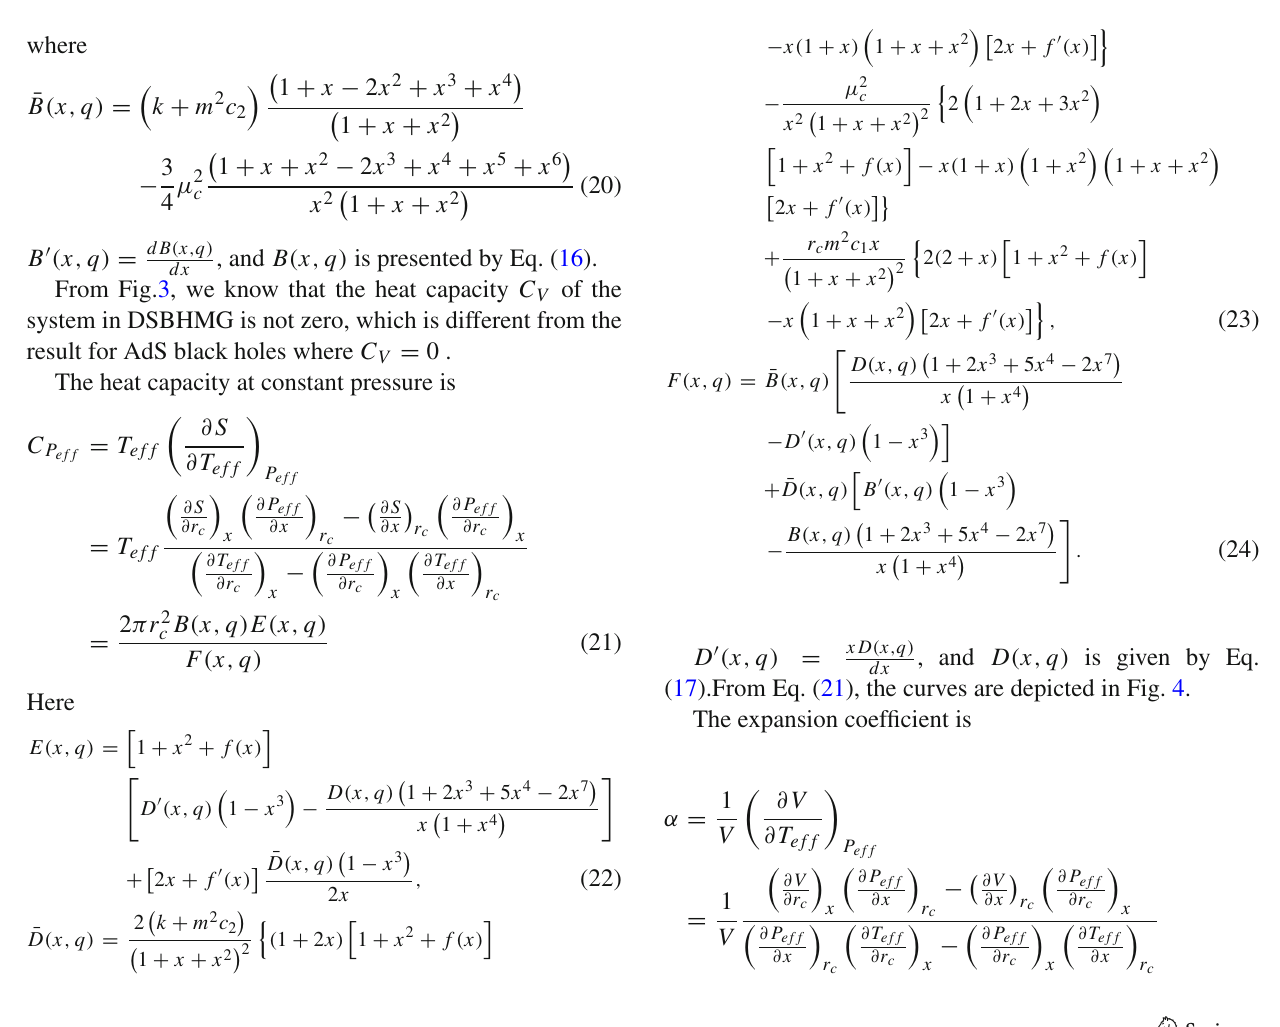
Fig. 3 C V − x diagrams when the parameters change respectively and the initial parameters m = 2 . 12, c 1 = 2, c 2 = 3 . 18, q = 1 . 7, r c = 1, k =